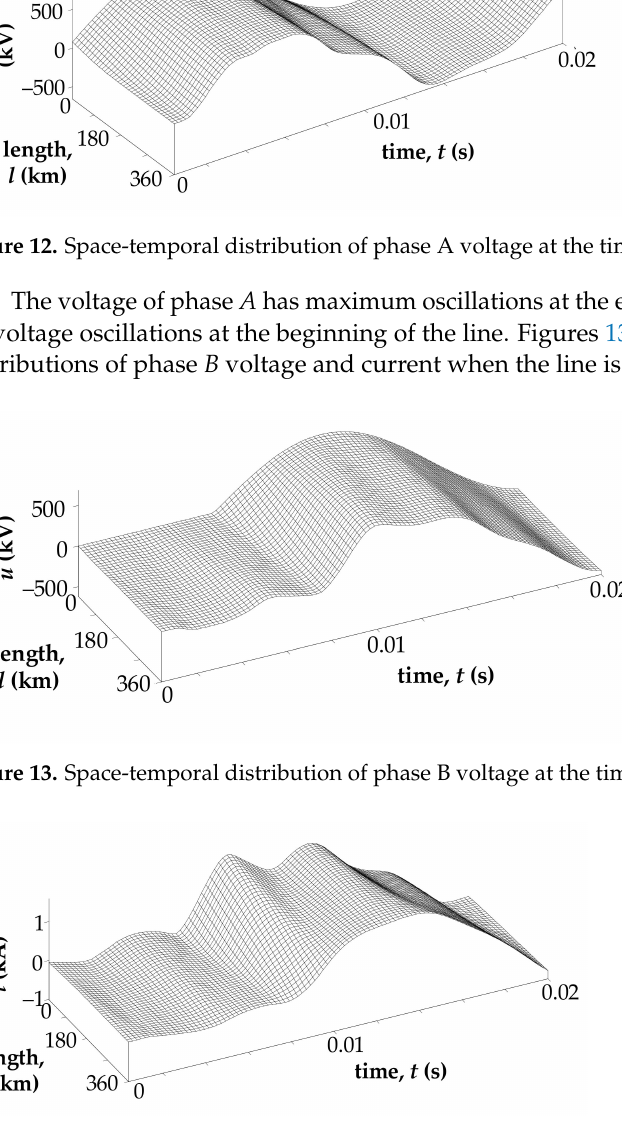
Figure 14. Space-temporal distribution of phase B current at the time t ∈ (0; 0.02)